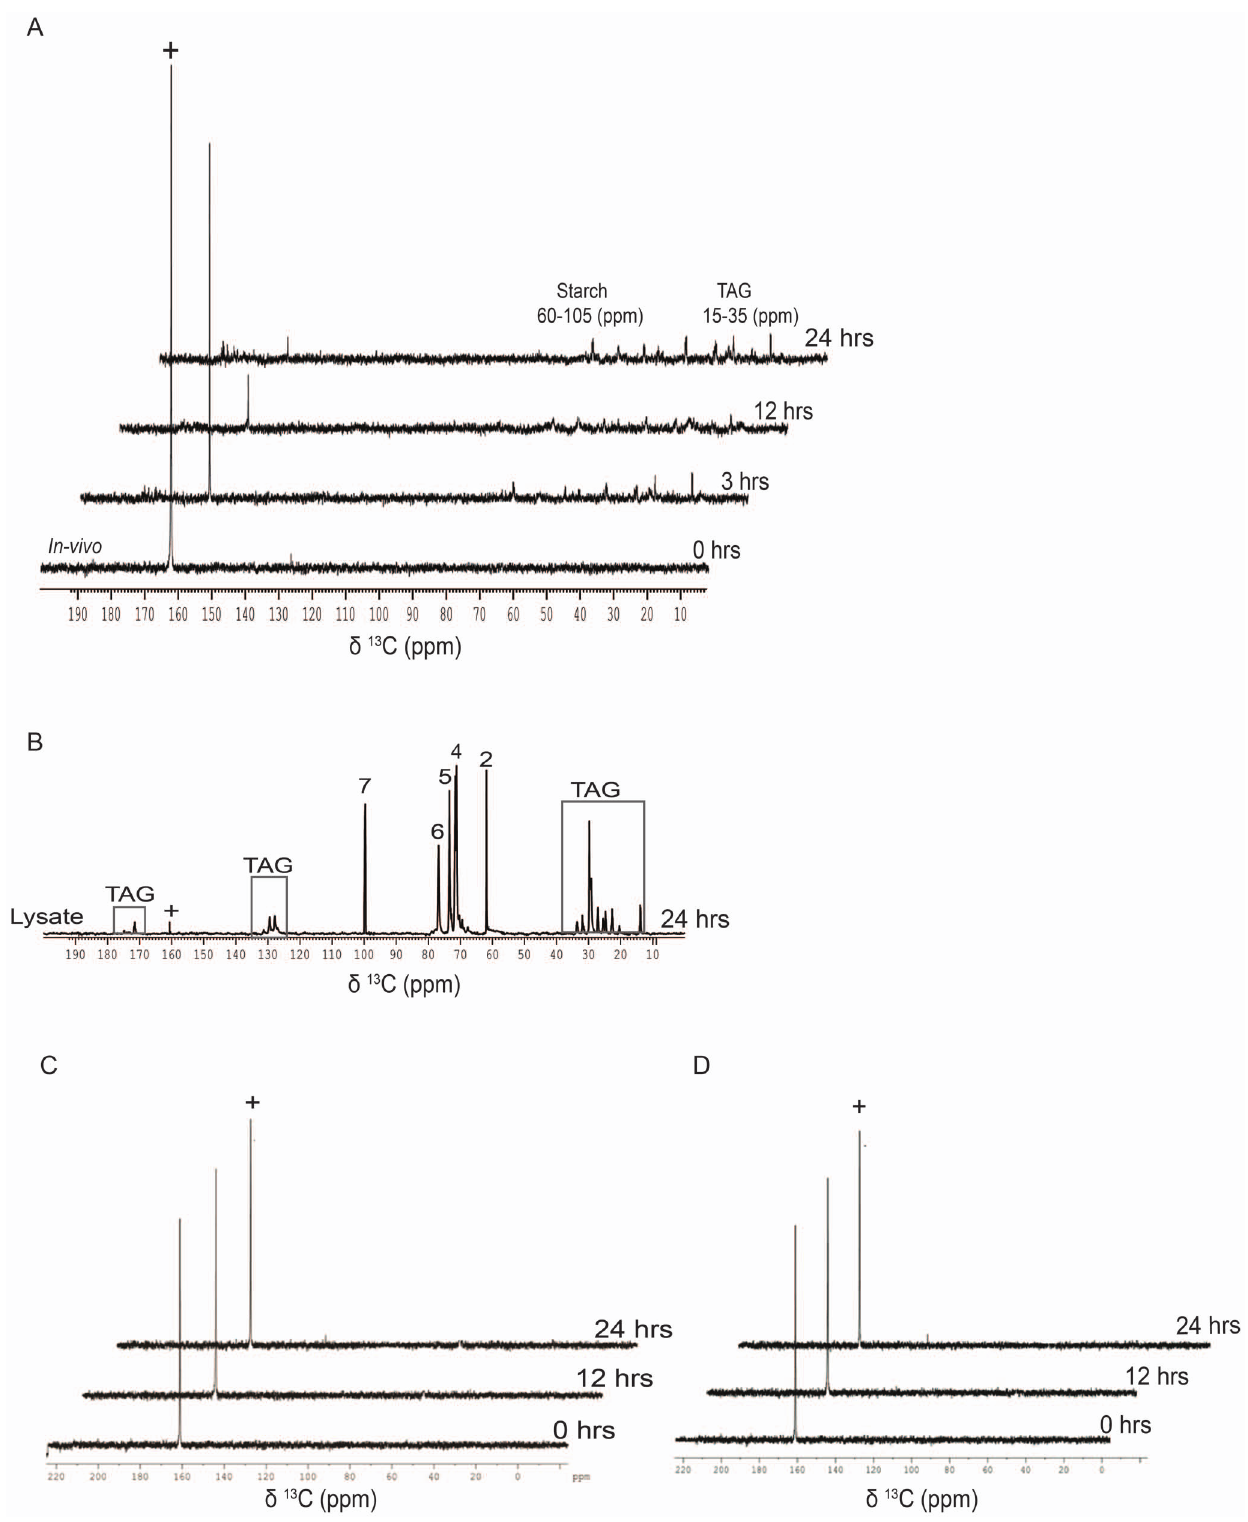
Figure 8. Assimilation kinetics of [ 13 C]-Sodium bicarbonate during autotrophy in C.reinhardtii . (A) Assimilation kinetics of C. reinhardtii , as studied by recording proton decoupled 1D [ 13 C]-NMR spectra during the light phase of growth (photoautotrophy) using [ 13 C]-bicarbonate. (B) [ 13 C]- NMR cell lysate spectrum of cells incubated in light for 24 hrs. (C) Assimilation kinetics of [ 13 C]-bicarbonate by C. reinhardtii , as studied by recording proton decoupled 1D [ 13 C]-NMR spectra, during the dark incubation control, and (D) atrazine treated cells in the light phase of growth (negative control of autotrophy) at different time points, following the addition of the 20 mM [ 13 C]- bicarbonate to the TP growth medium.